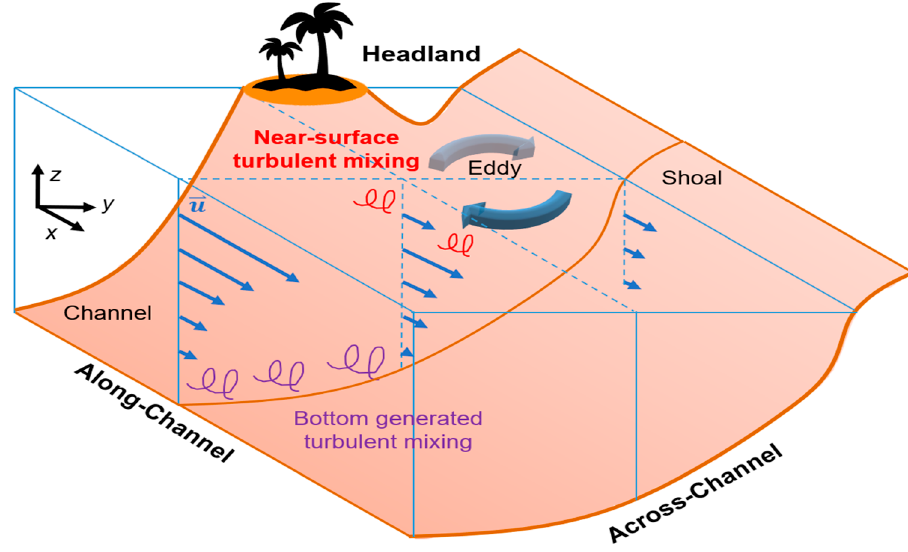
Figure 8. Conceptual diagram showing mechanisms creating enhanced turbulent mixing on ebb tide. The view is looking into the estuary from the sea. Near-surface mixing lies where increased lateral shear overlaps with increased vertical shear in streamwise currents. Relative direction and magnitude of streamwise currents are shown as blue arrows, the eddy as blue curved arrows, bottom-generated turbulent mixing as purple squiggles, and near-surface mixing as red squiggles.